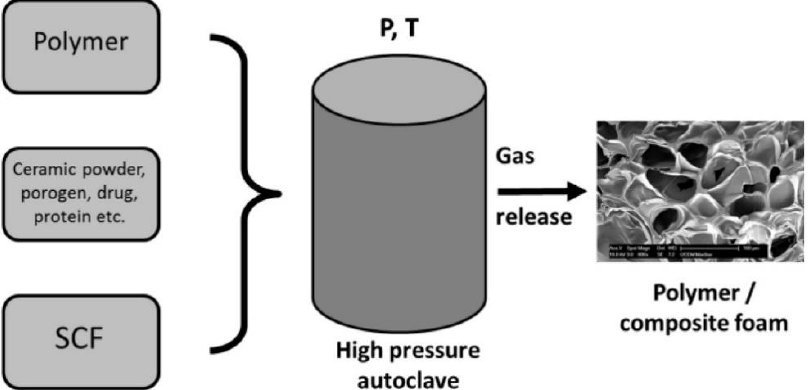
Figure 5. An illustration of the SC foaming leading to stabilized polymer/composite foams [105]. Reprinted from the Energy, 77, Knez et al., industrial applications of supercritical fluids: a review, 235 – 243, Copyright (2014), with permission from